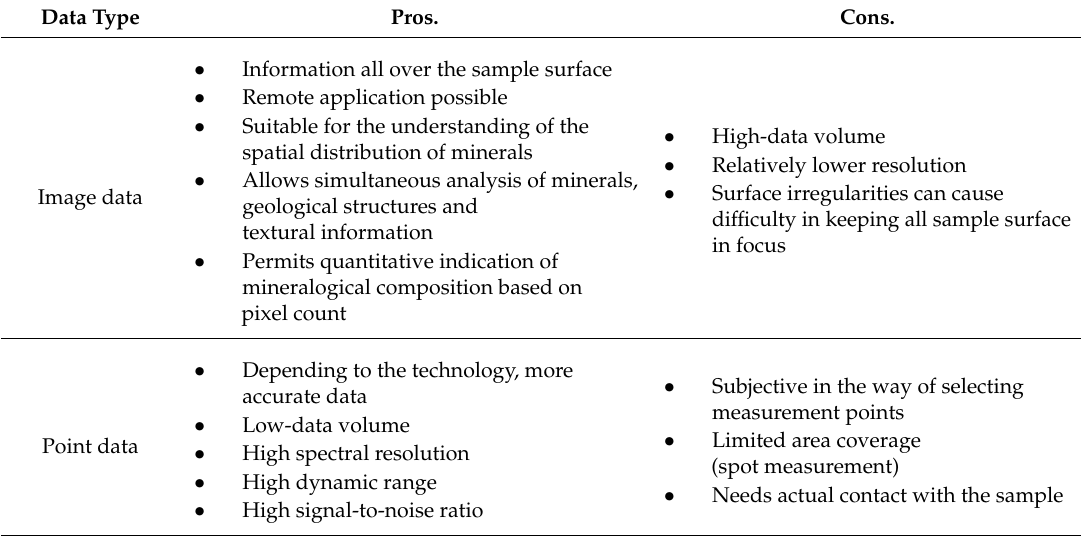
Table 2. Some of the benefits and shortcomings of point and image data types in material characterisation. Data Type Pros.